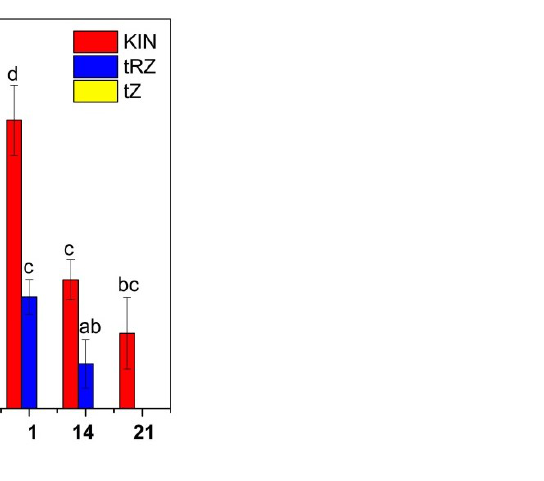
Figure 8. CK/IAA ratio during somatic embryogenesis of C. canephora . > 1, major CK/IAA ratio. < 1, minor CK/IAA. KIN/IAA (red), tZ/IAA (yellow), and tZR/IAA (blue). Different letters represent the statistical significance of mean differences between each determination at a given time according to the Tukey test ( p < 0.05).